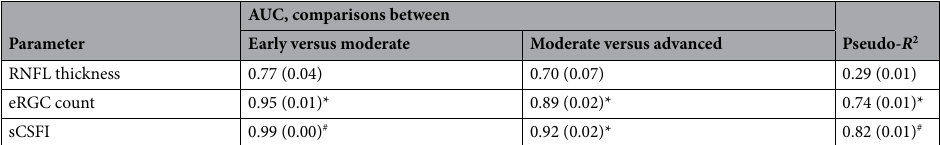
Table 3. Discriminatory ability of each parameter for different levels of visual field mean deviation (MD) loss for the glaucoma eyes. Comparisons were performed between glaucoma eyes that had early (MD > − 6 dB), moderate (MD − 6 to − 12 dB) and advanced (MD < − 12 dB) visual field loss. AUC, area under the receiver operating characteristic curve; RNFL, retinal nerve fiber layer; eRGC Count, estimated retinal ganglion cell count; sCSFI, simplified combined structure–function index; * = better compared to RNFL thickness at P < 0.001; # = better compared to RNFL thickness and eRGC count at P < 0.001.